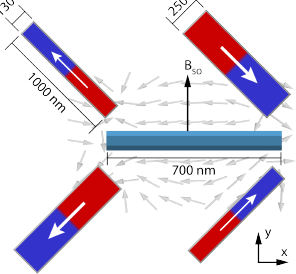
Figure 1: The Dragonfly setup with four micromagnets (blue / red) and an overlay of the magnetic field calculated with MuMax3 (gray arrows). The nanowire runs horizontally with the spin-orbit axis vertical, indicated by B